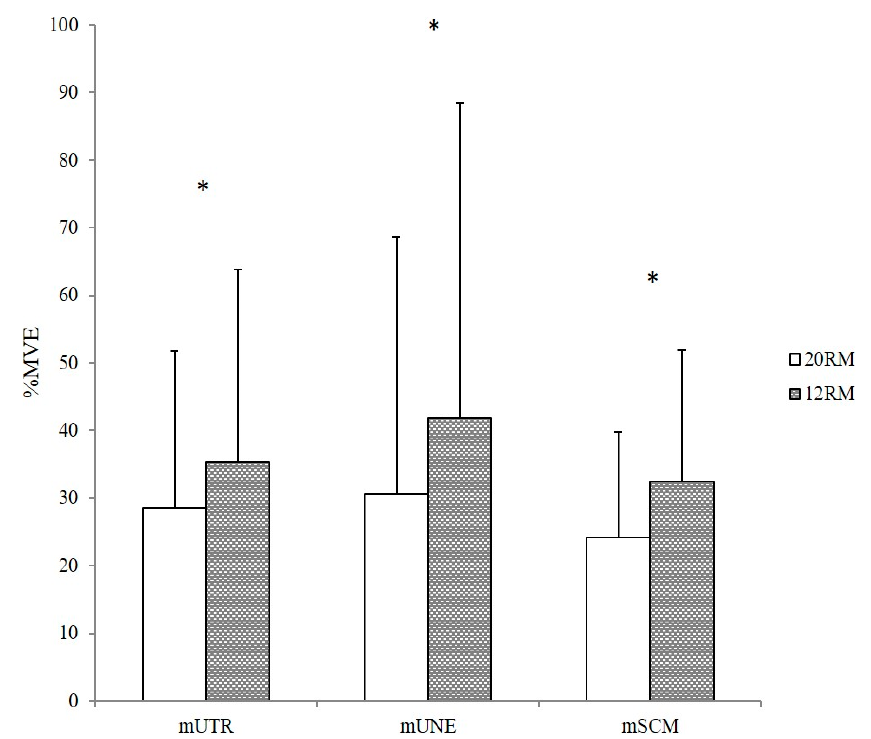
Figure 3. Mean muscle activity (%MVE) for all exercises in the upper trapezius muscle (mUTR), upper neck extensors muscles (mUNE), and sternocleidomastoideus muscles mSCM during intensities of 12RM and 20RM. * indicates significant difference between training intensities.